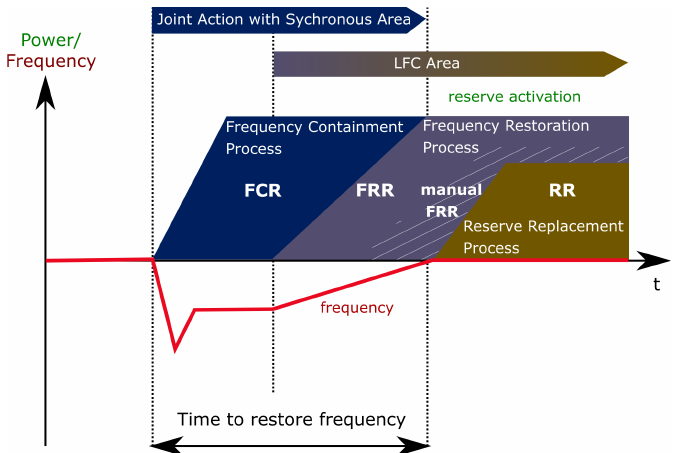
Figure 1. Hierarchy of Load-Frequency-Control (under assumption that Frequency Containment Reserve (FCR) is fully replaced by Frequency Restoration Reserve (FRR). FRR is commonly divided into automatic frequency restoration reserve (aFRR) and manual FRR.